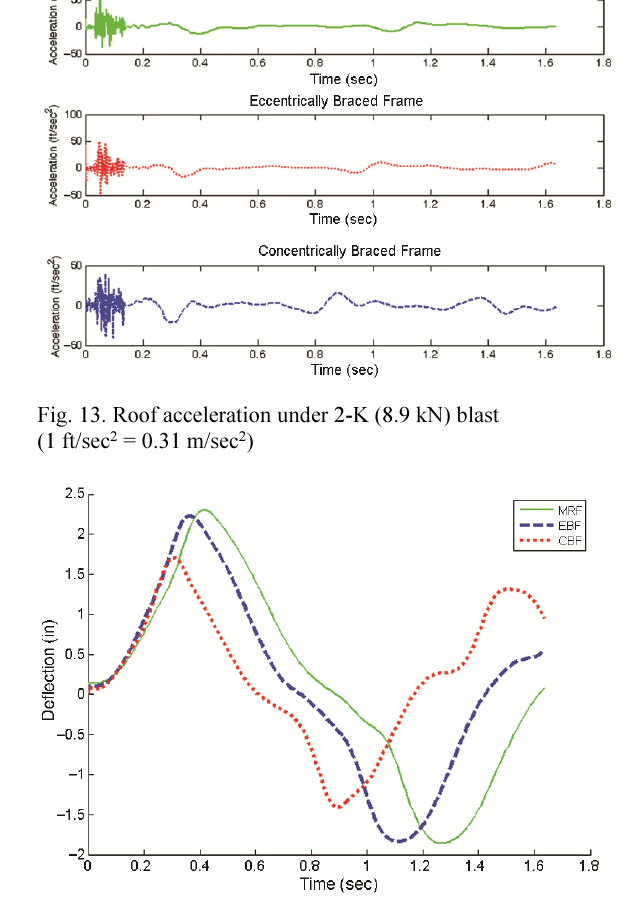
Fig. 14. Roof deflection under 4-K (17.8 kN) blast (1 in. = 25.4